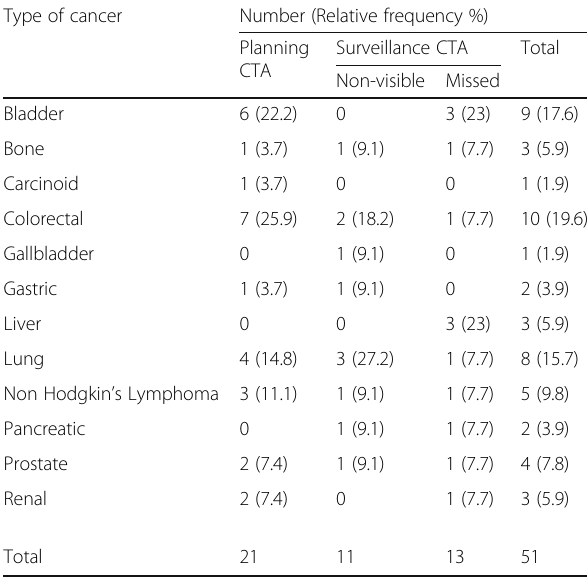
Table 2 Extravascular incidental malignant findings on planning and surveillance CT